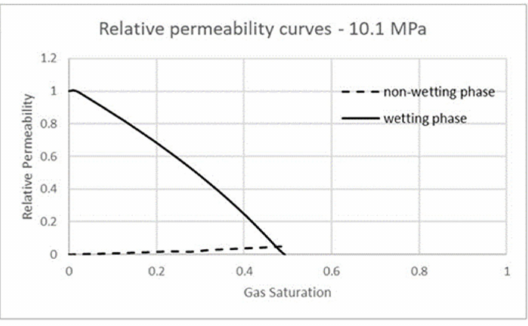
Figure 17. Relative permeability curves at inlet pressure of 10.1 MPa.